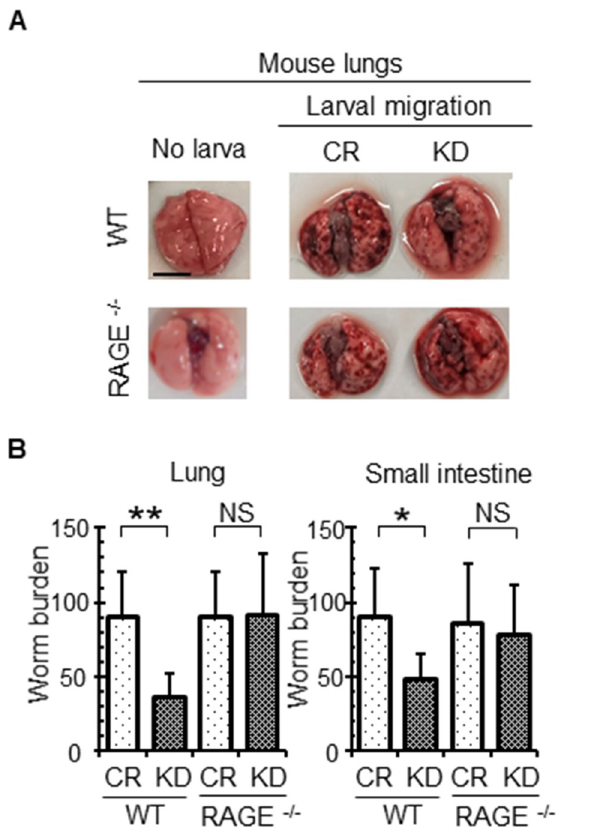
Fig 4. Effects of post-transcriptional silencing of the venestatin gene on larval migration of S . venezuelensis . (A) Venestatin-specific gene silencing alleviated lung hemorrhage induced by larval migration. Wild-type (WT) or RAGE- null (RAGE -/- ) mice were infected with 2,000 LL3s treated with ds luciferase (CR) or ds venestatin (KD). Petechial hemorrhage in the lungs was observed on day 3 (72 h) p.i. Scale bar: 1 cm. (B) Venestatin-specific gene silencing reduced worm burden in the lungs. Lung and small intestinal larval burdens are shown from WT or RAGE -/- mice on days 3 (72 h) and 4 (96 h) p.i., respectively. Data are expressed as means ± SDs of 10 mice from two independent trials. � p < 0.01; �� p < 0.001. NS, no significant